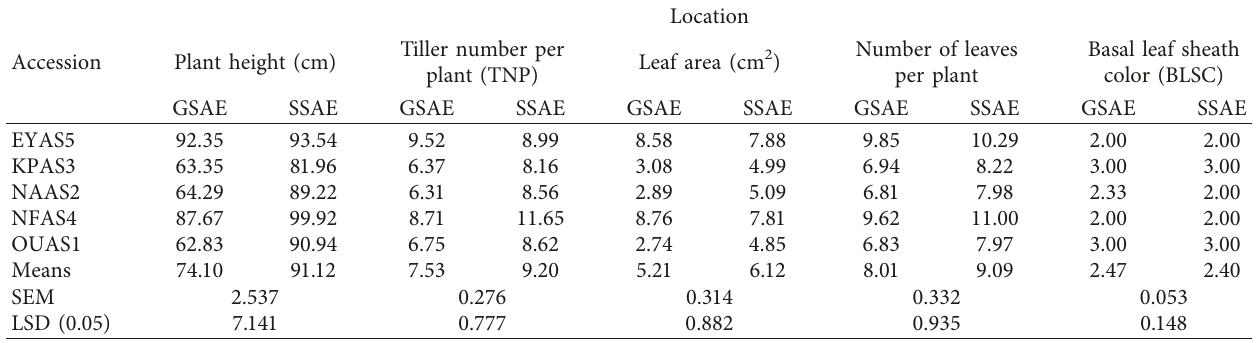
Table 6: Influence of accession X location interaction on growth parameters.